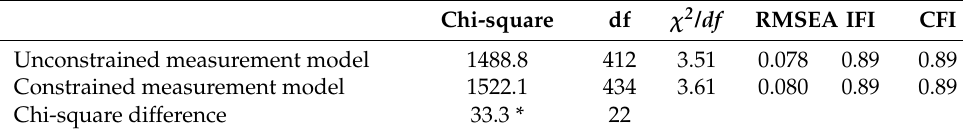
Table 6. Measurement invariance test between locals and tourists.